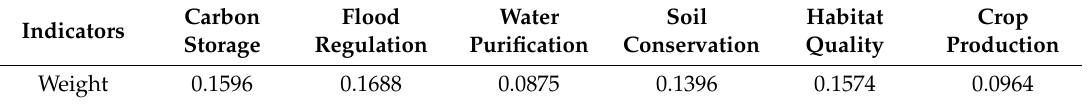
Table 3. Index weights of each ecosystem service (ES) for the ecological conservation